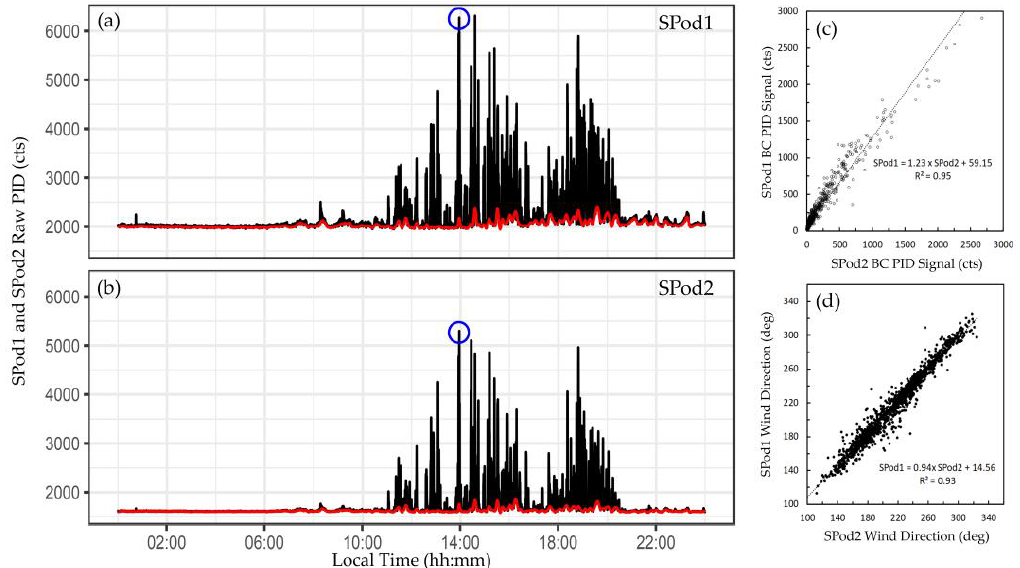
Figure 2. Example of collocated SPod data from 7/17/19: ( a , b ) SPod1 (top panel) and SPod2 (bottom panel), 10 s average timeseries (black traces) with superimposed baseline correction fits (red traces), blue circles indicate expanded view during CGS acquisition shown in Figure 3, ( c ) SPod PID comparison of 1-min background-corrected data, ( d ) SPod wind direction comparison of 1-min data.